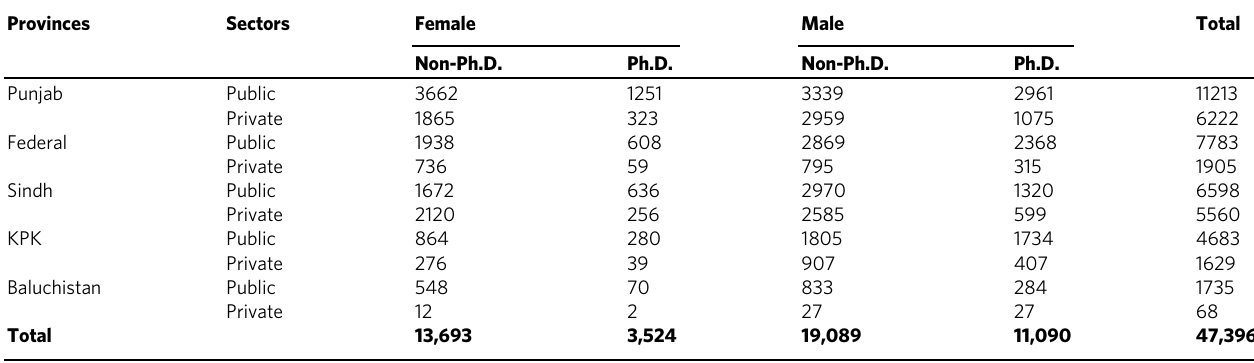
Table 1 Number of Ph.D. and non-Ph.D. Faculty Members in the Universities. Provinces